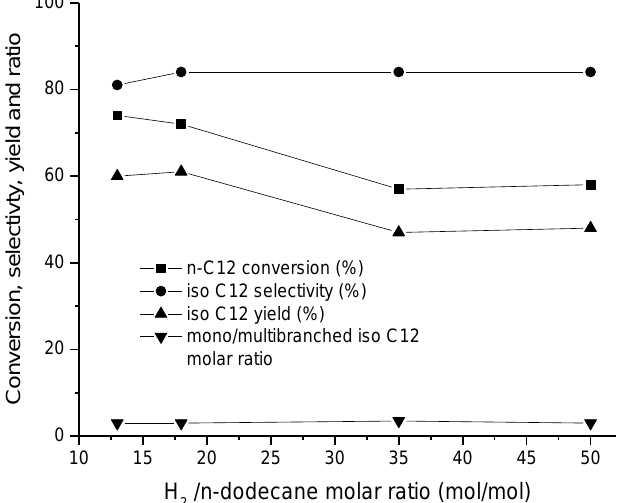
Figure 14. Conversion, selectivity, yield of isomer, and ratio between mono/multibranched isomers in dodecane hydroisomerization over Ni x P y -SAPO-11 as a function of H 2 /feed molar ratio [26]. Reproduced with permission from Tian et al., Fuel Process. Technol. ; published by Elsevier, 2014 .